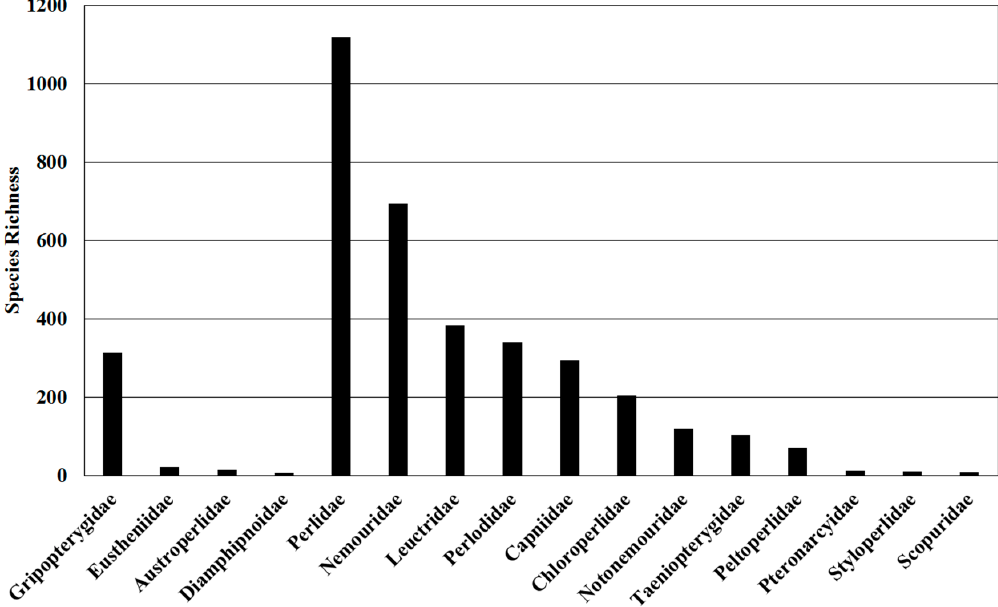
Figure 2. Species richness of Plecoptera families at the global scale.